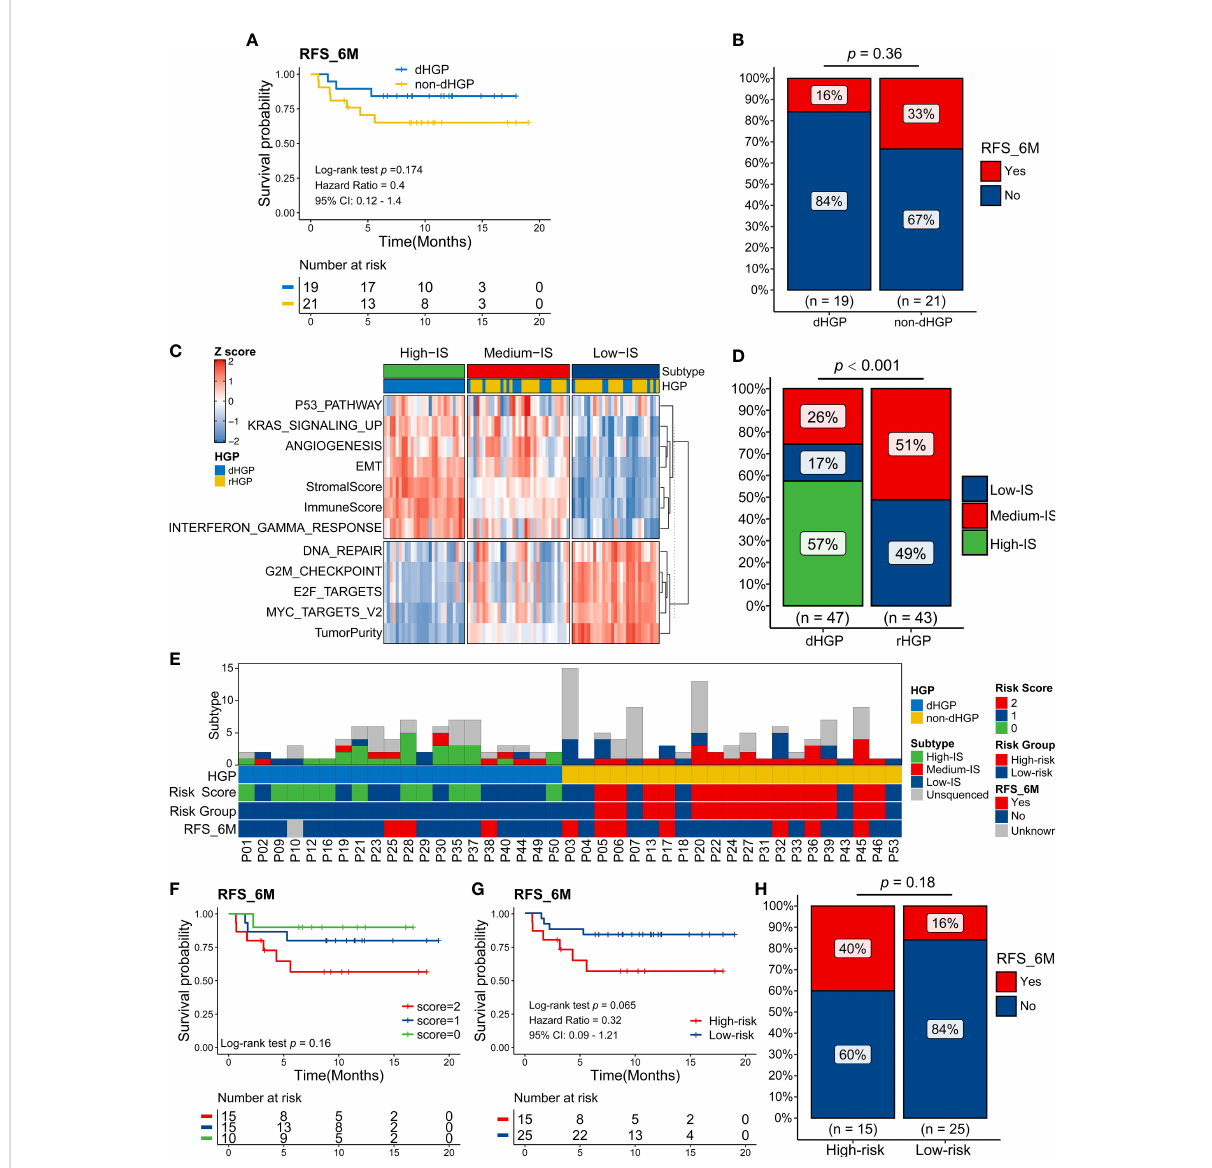
FIGURE 6 Exploration in the predictive value of the HGP type and transcriptome subtype of liver metastases for the survival of CRLM patients. (A) Kaplan- Meier curves for 6 months Relapse-Free Survival (RFS6M) of 19 dHGP patients and 21 non-dHGP patients (Log-rank test, p = 0.174). (B) Rate of early relapse events within 6 months (RFS_6M, Yes and No) in dHGP or non-dHGP subgroups (Chi-square test, p = 0.36). (C) Unsupervised clustering of important HALLMARK pathways and TIME-relevant molecular signatures among 90 liver metastases. Rows represent scores of various signatures, and columns represent samples. (D) Rate of three transcriptome subtypes in dHGP or non-dHGP subgroups (Chi-square test, p < 0·001). (E) Heatmap showing the transcriptome subtypes, HGP, risk score, risk subgroup, and early relapse event within 6 months of each patient. (F) Kaplan-Meier curves for RFS6M of patients with different risk scores (Log-rank test, p = 0.16). (G) Kaplan-Meier curves for RFS6M of patients with different risk subgroups (Log-rank test, p = 0.065). (H) Rate of early recurrence events within 6 months (RFS_6M, Yes and No) in high-risk or low-risk subgroups (Chi-square test, p =